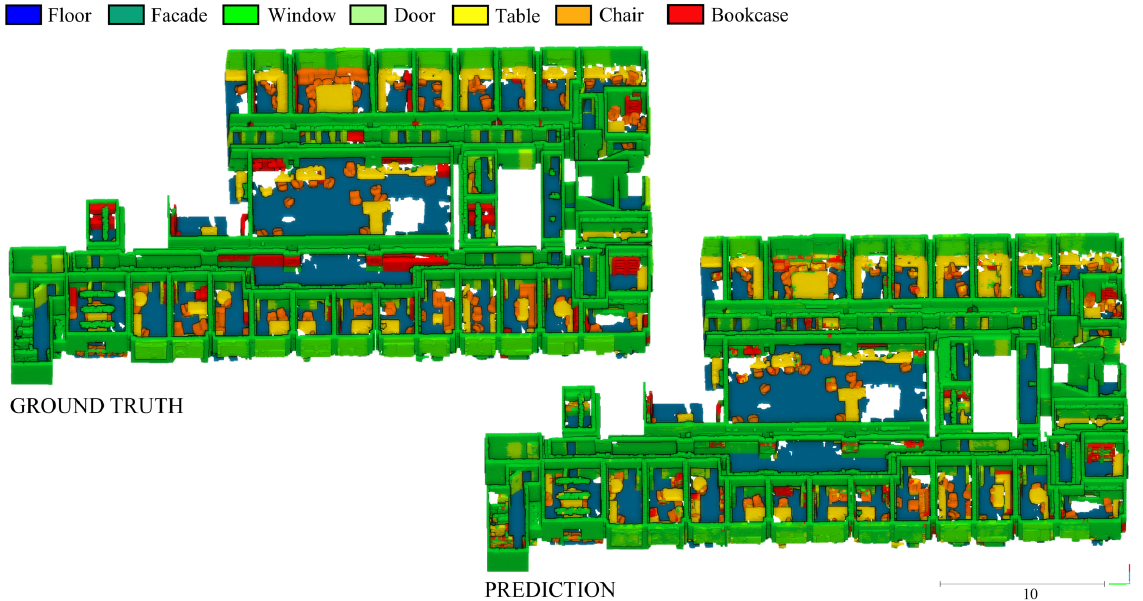
Figure 9. Visual comparison between the hand-annotated S3DIS dataset (left) and the prediction achieved using the proposed method (right).